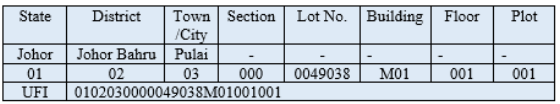
Table 2. Example of UFI